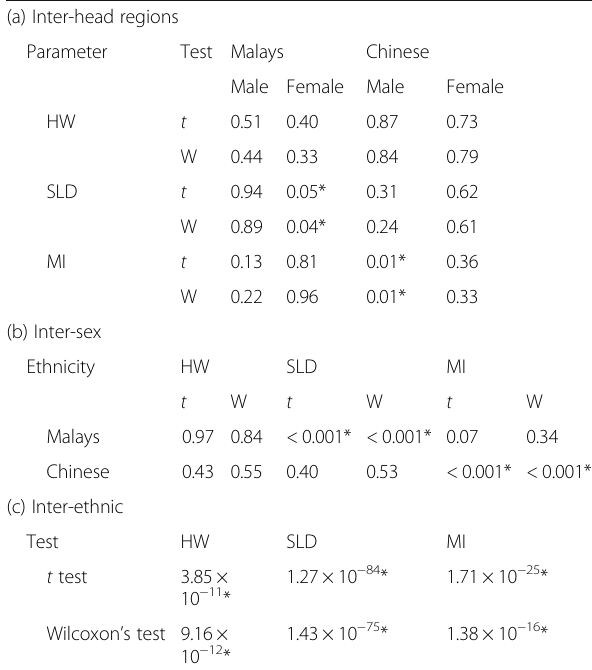
Table 3 Statistical test results of t test ( t ) and Wilcoxon ’ s rank sum test (W) (a) Inter-head regions